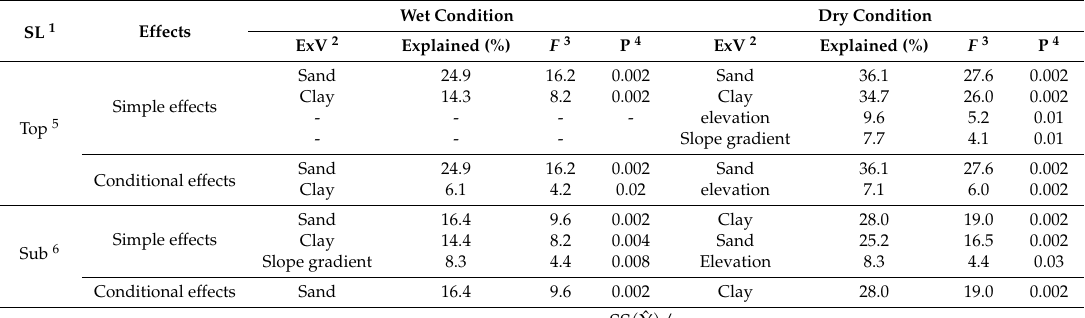
Table 6. Results of summarized effects of explanatory